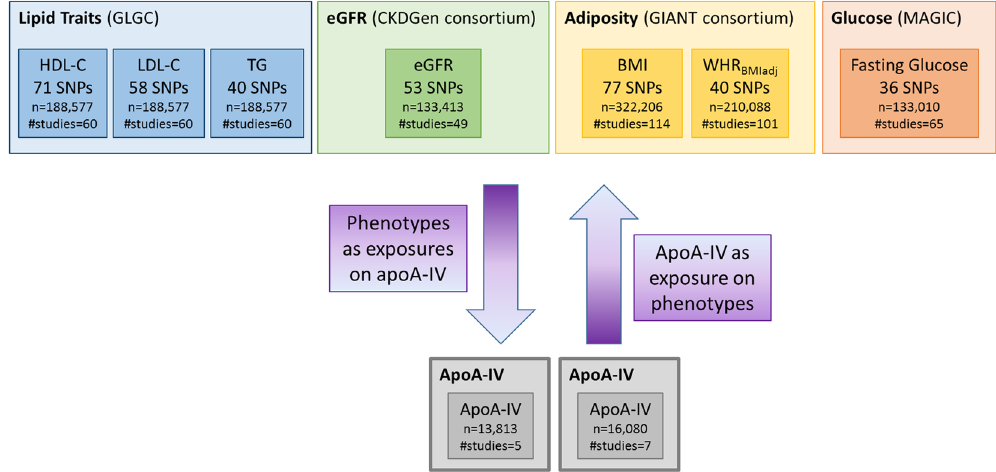
Figure 1. Graphical overview of the study design. Seven biomarkers out of four consortia (GLGC 18 ; CKDGen consortium 33 ; GIANT consortium 34, 60 ; MAGIC 35, 36 ) were included as well as results from a GWAS meta- analysis on apoA-IV 17